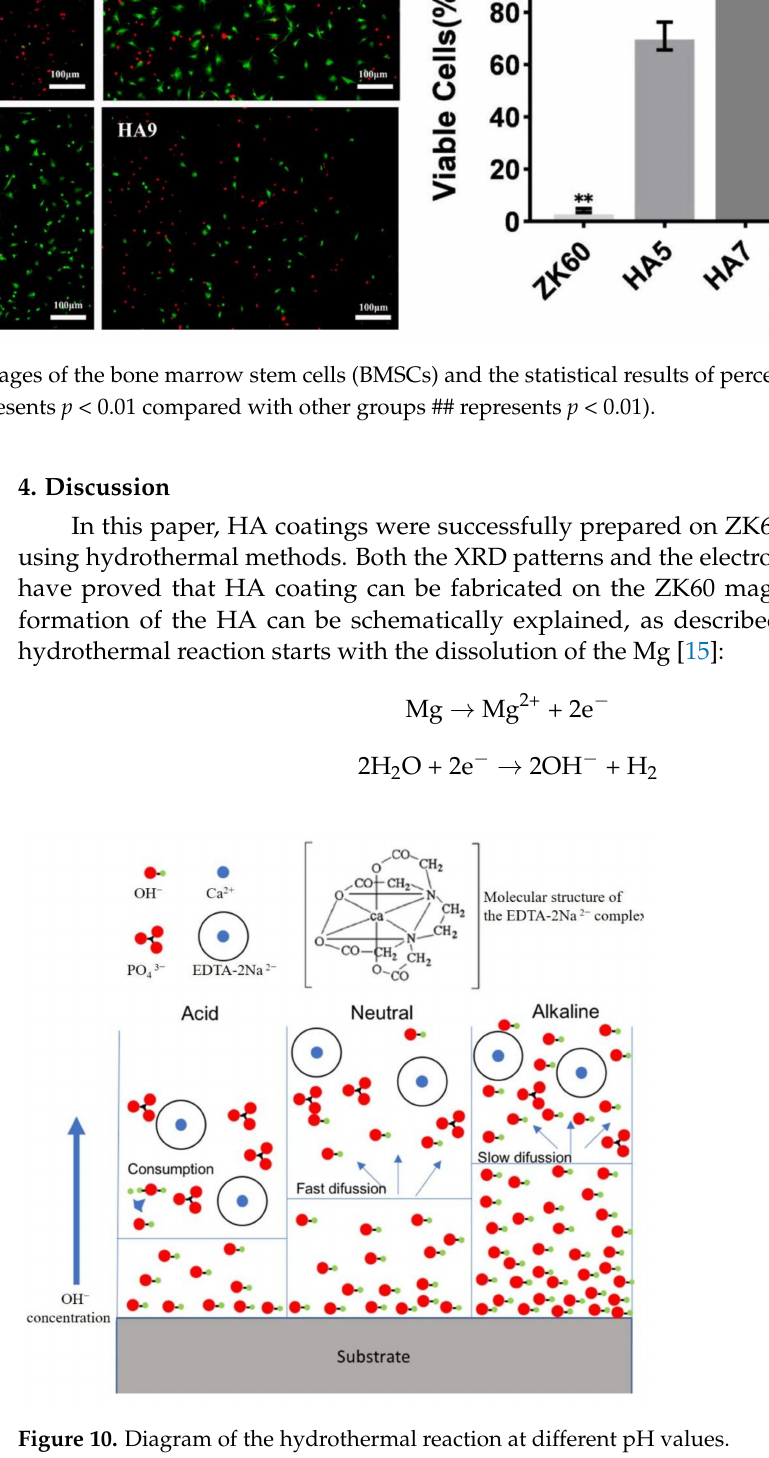
Figure 10. Diagram of the hydrothermal reaction at different pH